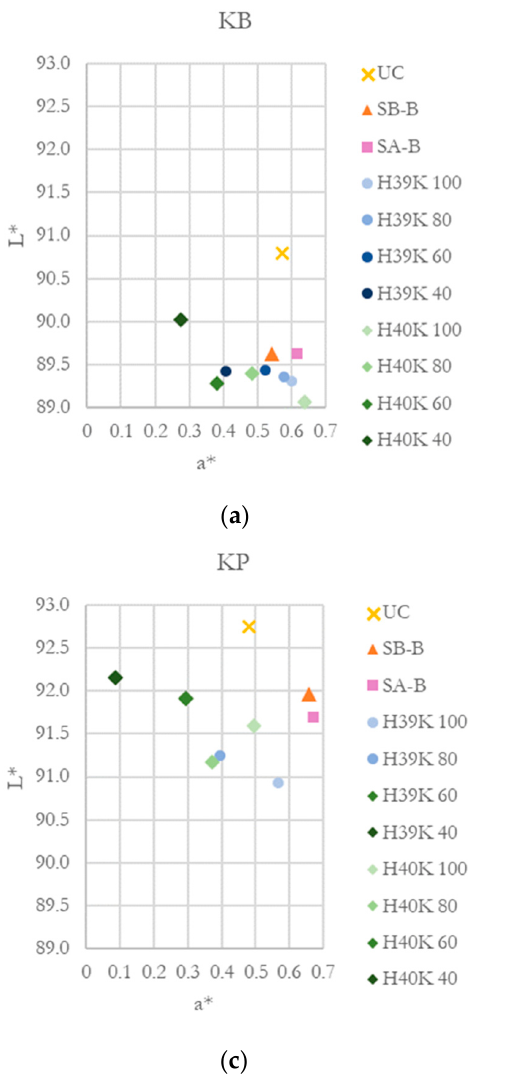
Table 3. Experimental coating formulations for the HPH 39 and HPH 40 styrene-butadiene latex. Substrate